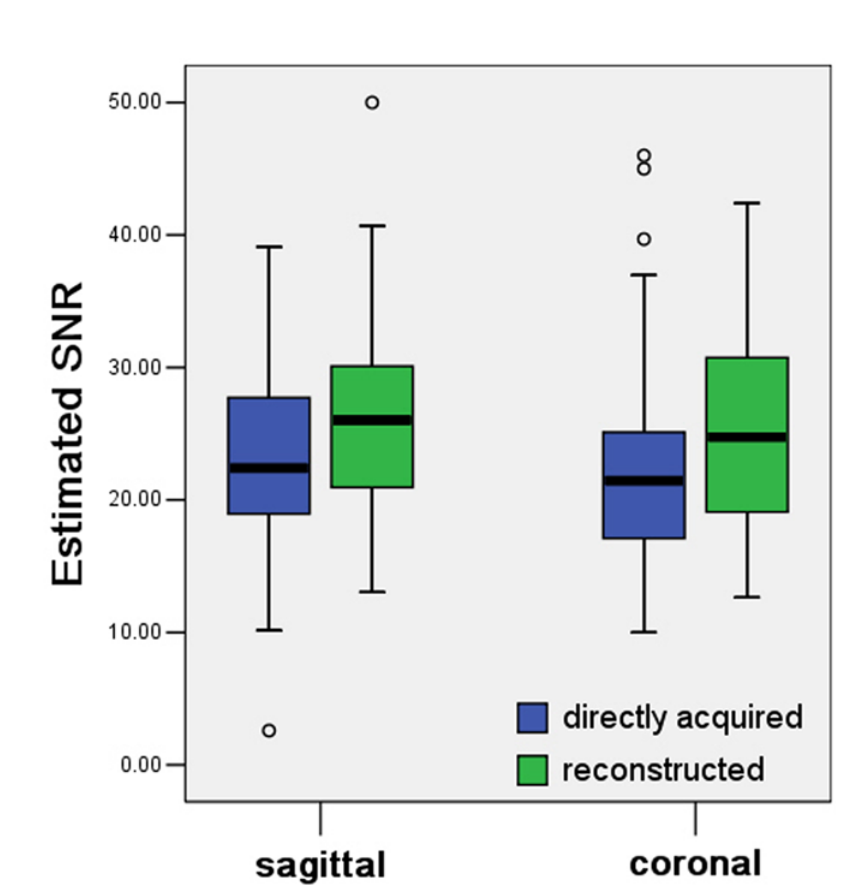
Fig 1. Box and whisker plots of estimated SNR of myometrium. The estimated SNRs of the myometrium in reconstructed images are higher than those in directly acquired images of both sagittal and coronal plane ( p = 0.001 and 0.002,